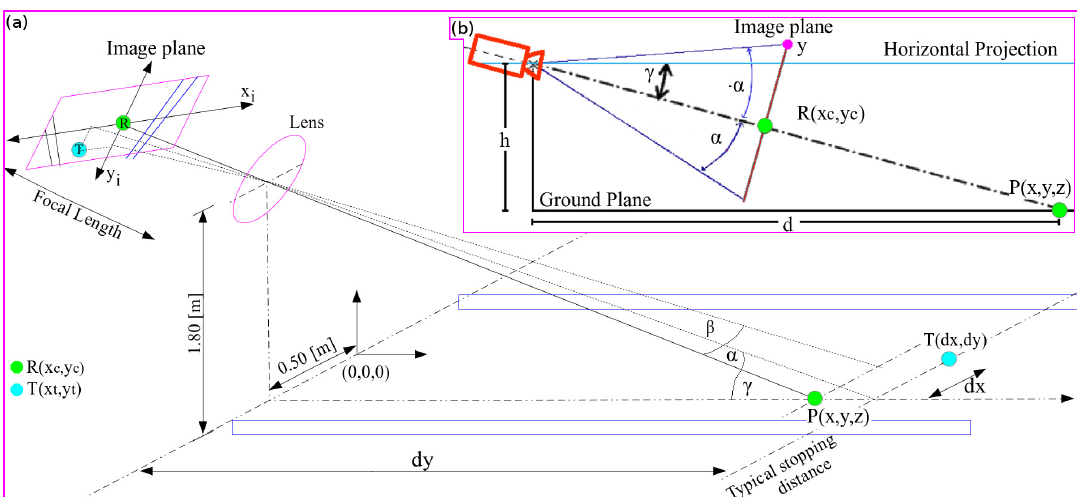
Figure 2. Sensor coordinate system. ( a ) shows the perspective projection; and ( b ) shows the lateral projection. The center of the coordinate system is located at the vehicle centerline, 2.3 m from the vehicle front bumper. The camera is located at a height of 1.8 m, 0.5 m to the right of the vehicle centerline. The camera is tilted down at 9 ◦ with respect to the horizontal projection. The laser sensor is located at the vehicle centerline at the height of 1.7 m, tilted down 7.5 ◦ .